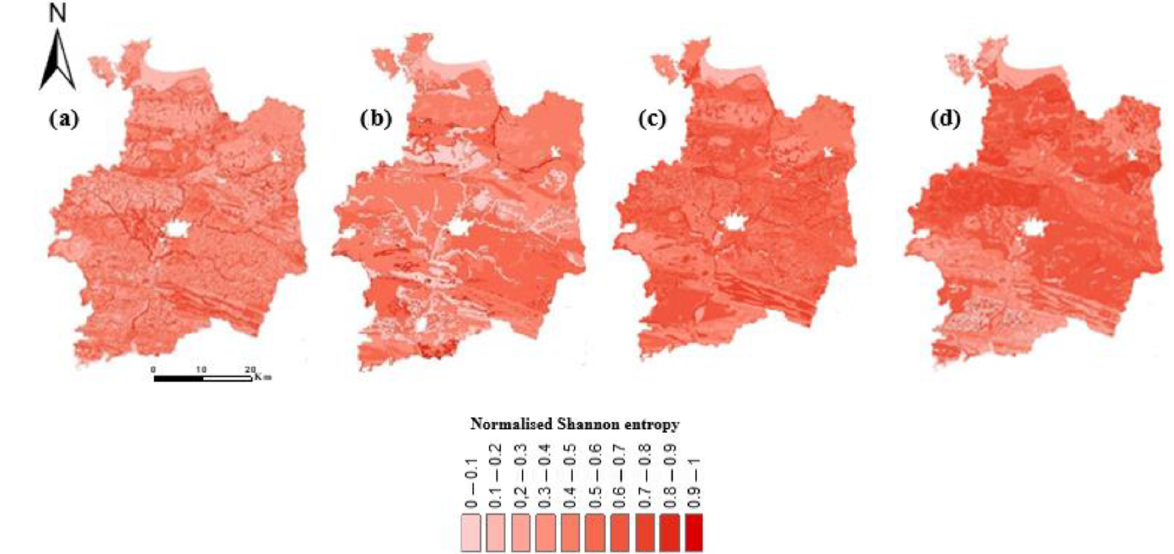
Figure 8. Spatial association between the disaggregated maps of the Ille-et-Vilaine region. (a) Map of the inhomogeneity of DSMART with the soil landscape relationship map in terms of the original DSMART map. (b) Map of the inhomogeneity of the original DSMART map in terms of DSMART with the soil landscape relationship map. (c) Map of the inhomogeneity of DSMART with soil landscape relationship map in terms of DSMART with extra soil observations map. (d) Map of the inhomogeneity of DSMART with the extra soil observations map in terms of DSMART with the soil landscape relationship map. Inhomogeneity (variance) is measured by the normalised Shannon entropy.